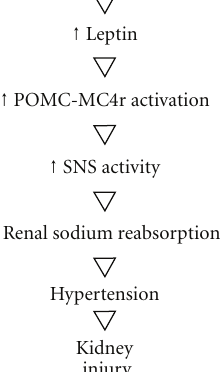
Figure 2: Leptin